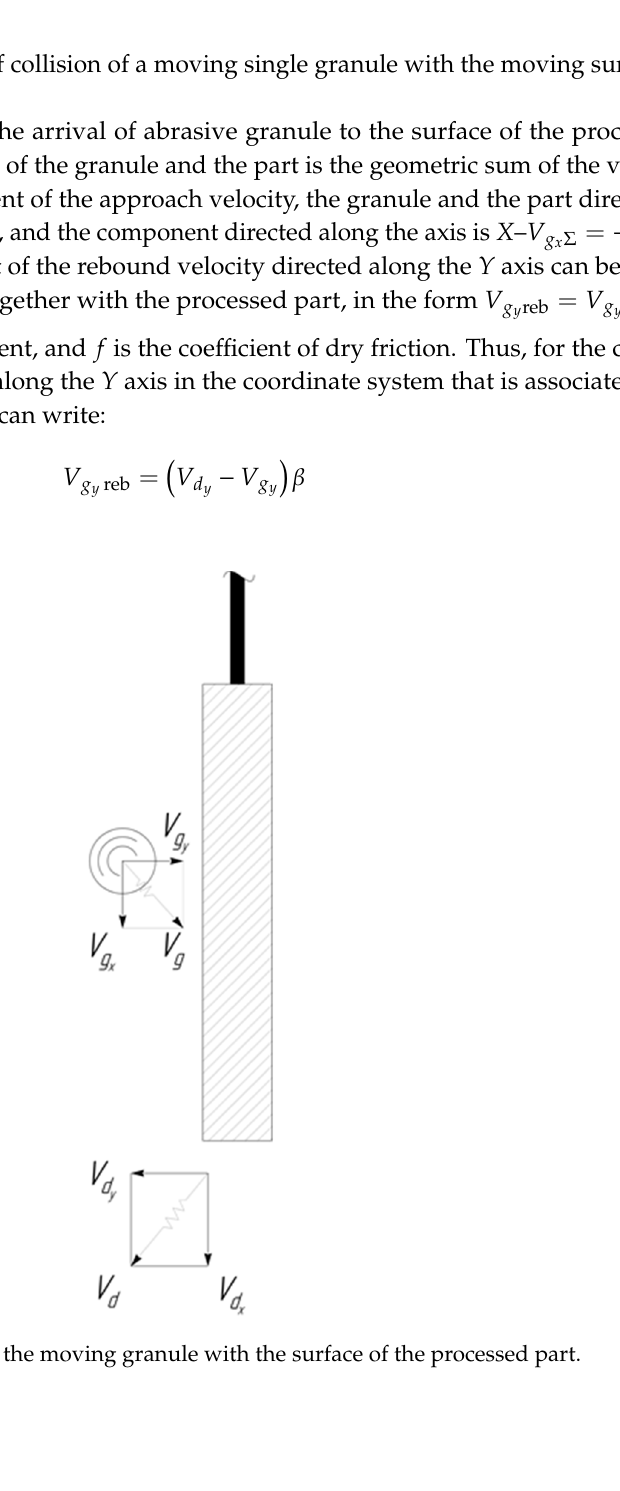
Figure 3. Change in the velocity component of the granule along the X axis after its collision with the processed part ( ) F N ft fr = .